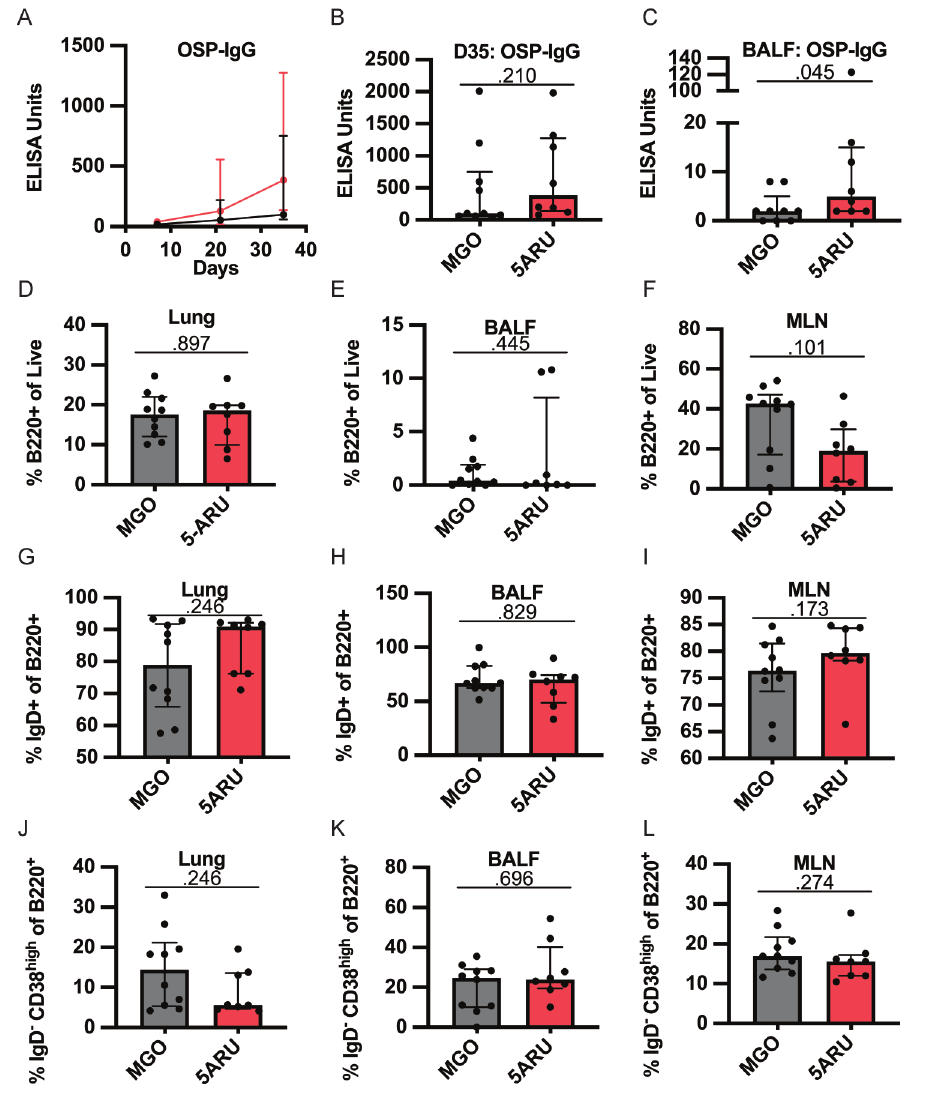
Figure 5. Intranasal 5-A-RU administration results in moderately higher mucosal polysaccharide responses. ( A ) Serum time-course, ( B ) serum day 35 endpoint, and ( C ) BALF day 35 endpoint OSP-IgG ELISAs. Data are represented as ELISA units measured kinetically and normalized to positive control pooled serum from WT B6 mice intranasally vaccinated with live V. cholerae . ( D-F ) Frequency of total B cells (B220 + ) as a percentage of live cells in ( D ) lung, ( E ) BALF, and ( F ) MLN. ( G-I ) Frequency of naive B cells (IgD + ) as a percentage of B220 + cells in ( G ) lung, ( H ) BALF, and ( I ) MLN. ( J-L ) Frequency of class- switched memory B cells (IgD - CD38 High ) as a percentage of B220 + cells in ( J ) lung, ( K ) BALF, and ( L ) MLN. Data are represented as Median with IQR from 2 independent experiments. n=8-10 mice per group. P values determined by 2-tailed Mann-Whitney U